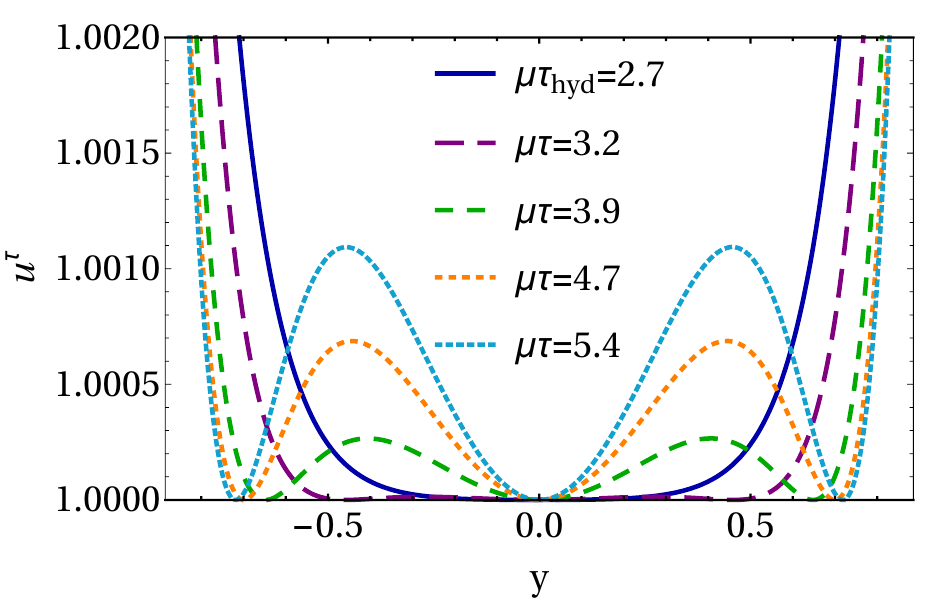
Figure 16 . The component of the four-velocity (cid:12)eld along the proper time direction at (cid:12)x proper times for the most non-conformal con(cid:12)guration of (cid:12)gure 15, (cid:30)